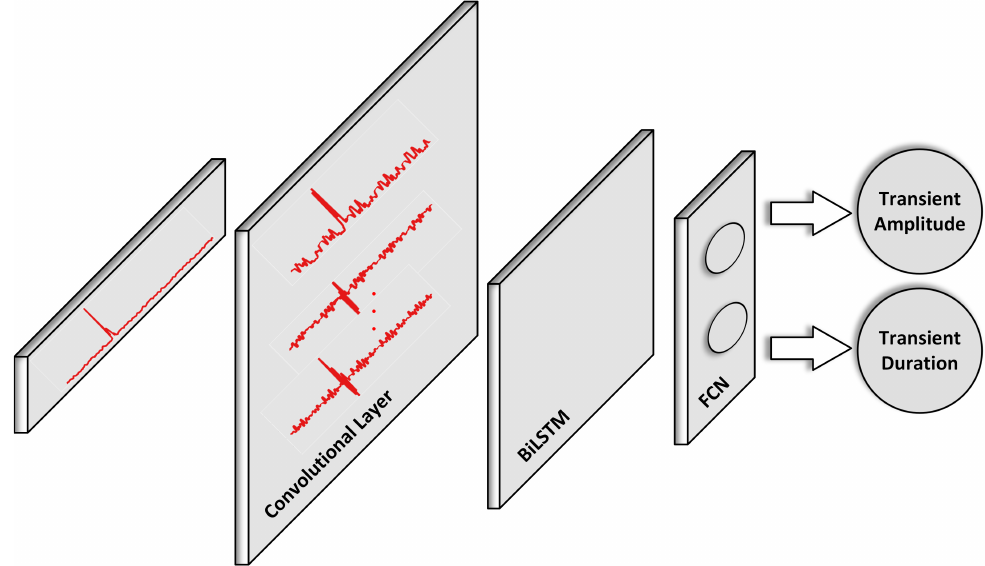
Figure 9. Hybrid CNN–BiLSTM topology for the second step, which receives the absolute difference from the output of the first 1D CNN as well as the acquired data and estimates the transient duration and amplitude.